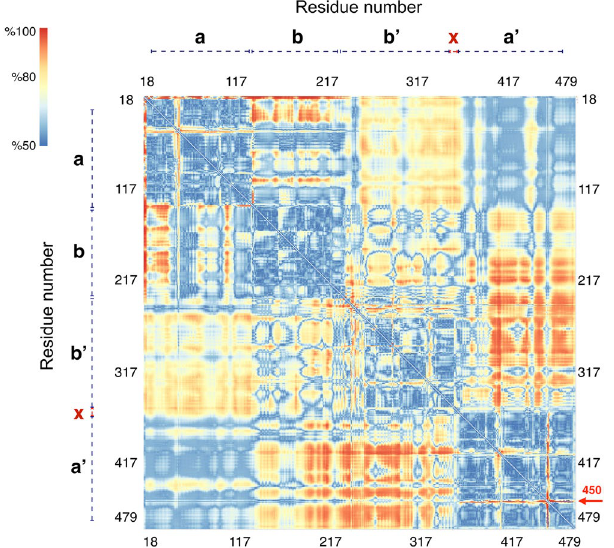
Figure 6. Pairwise residue discrimination matrix between oxidized and reduced state of hPDI. Values range from 50% (blue) to 100% (red) discrimination